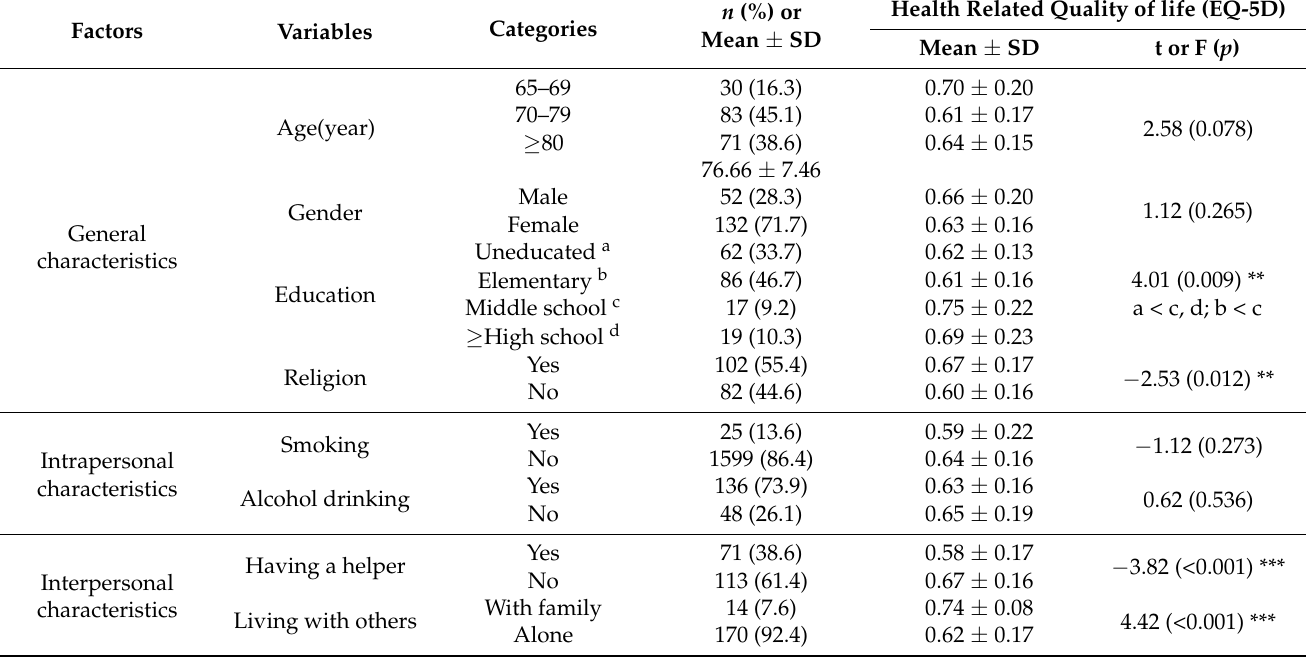
Table 1. Differences in Health-Related Quality of Life according to General Characteristics, Intraper- sonal and Interpersonal Characteristics of Participants ( N =